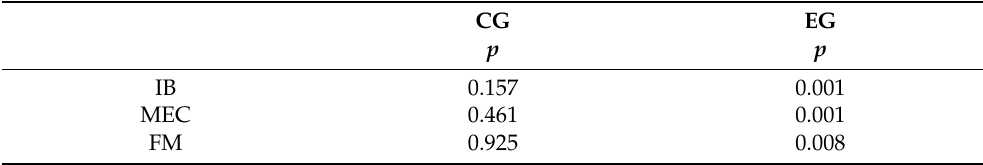
Table 3. Comparison of initial and final CG and EG.